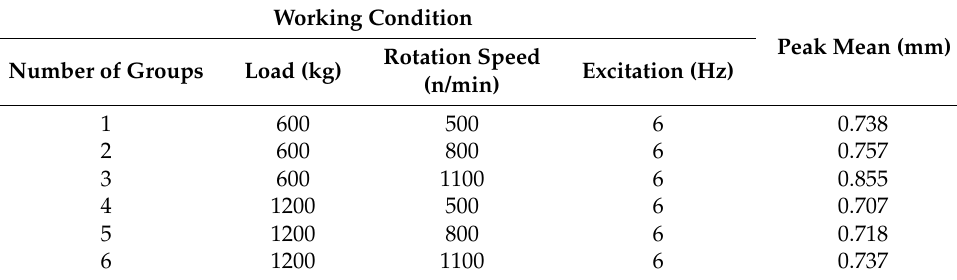
Table 7. Mean peak values of displacement amplitudes under different working